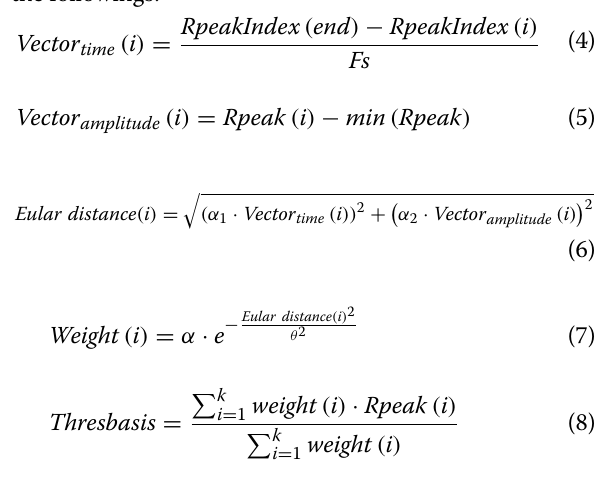
distance as the final similarity vector. Finally, we select K elements according to the similarity obtained above to calculate the next detection threshold of QRS